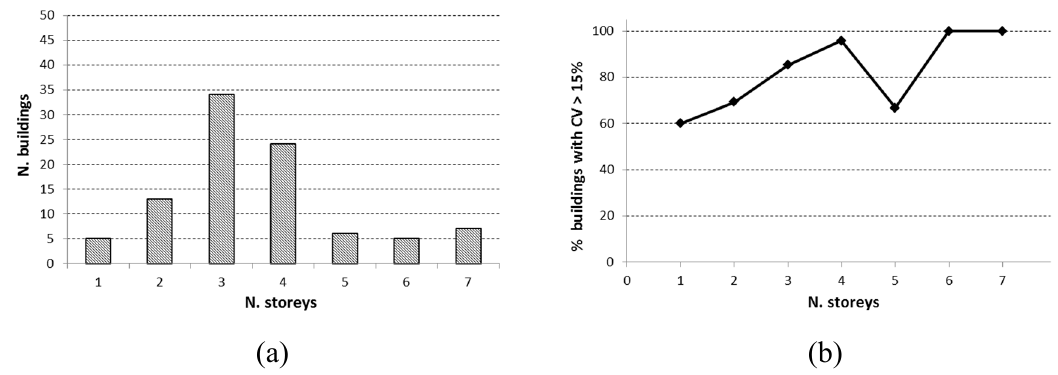
Figure 6. ( a ) Distribution of buildings by number of storeys; ( b ) number of buildings with CV higher than 15%.